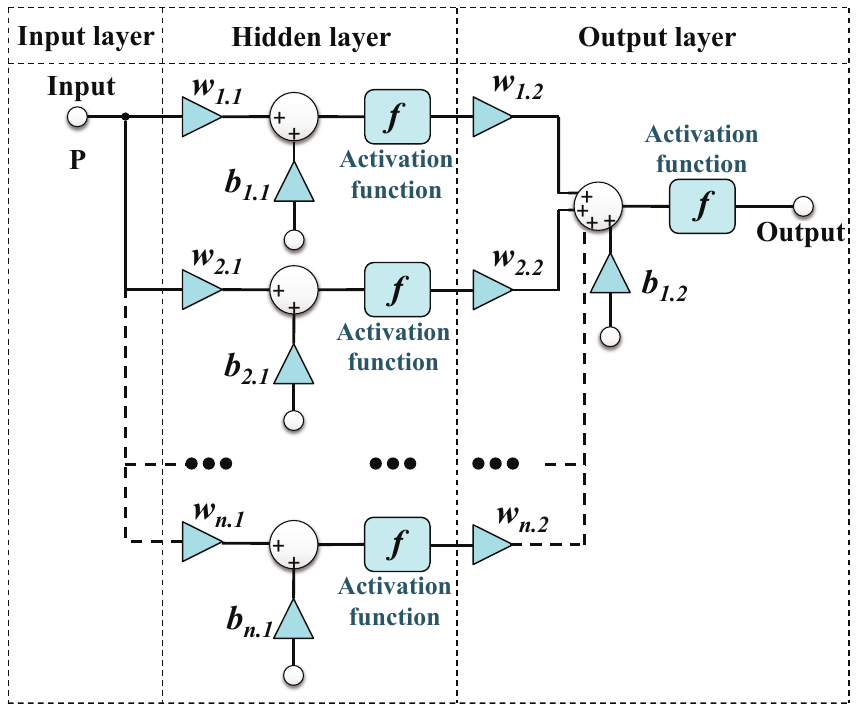
Figure 5. Multilayer perceptrons neural networks